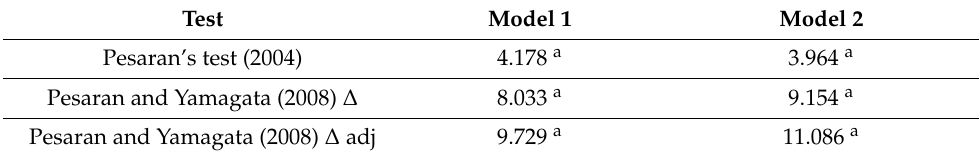
Table 4. Results of cross-sectional dependence (CD) and the slope homogeneity tests.